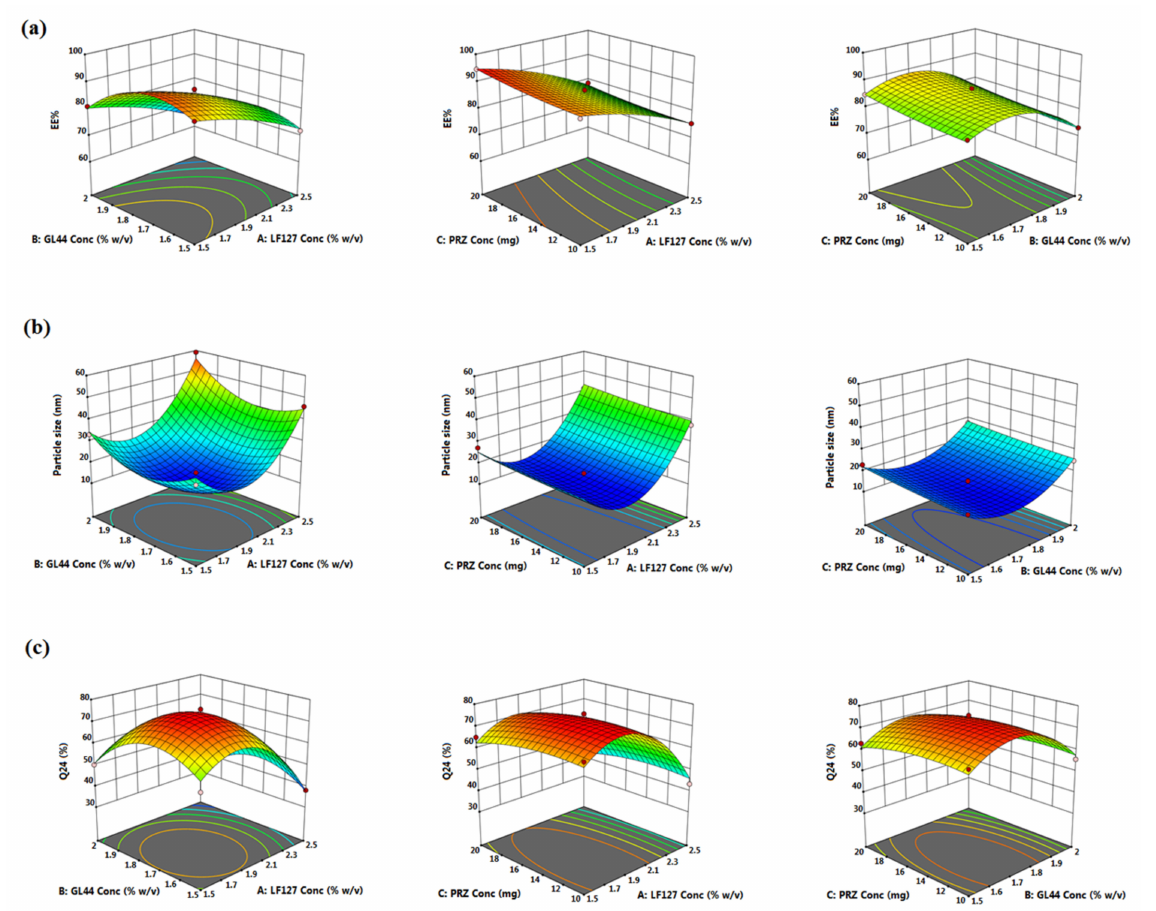
Figure 1. 3D surface plots for the impact of LF127 ( X 1 ), GL44 ( X 2 ) and PRZ ( X 3 ) concentrations on ( a ) EE% ( Y 1 ), ( b ) micelle size ( Y 2 ) and ( c ) Q 24 ( Y 3